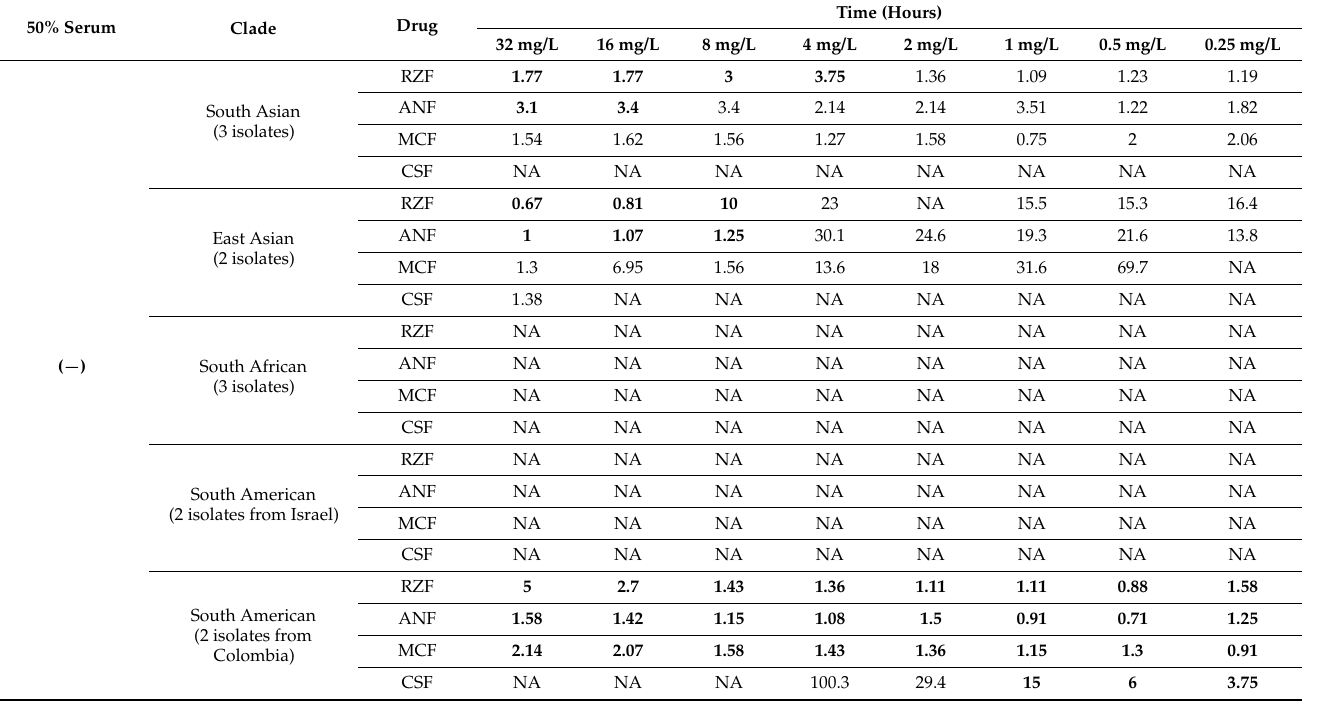
Table 2. Average time (hours) to reach 50% growth reduction (T 50 = 0.30103/ k ) from the starting inocula at different rezafungin (RZF), anidulafungin (ANF), caspofungin (CSF), and micafungin (MCF) concentrations in RPMI-1640 − /+ 50% human serum against 4 Candida auris clades. Data of the type strain (NCPF 13029 = CBS 10913) were not included in the data of the East Asian clade. Data in bold indicate that k values were positive (indicating killing) for all isolates within a clade, all other data (nonbold) indicate that one or two isolates never reached 50% growth reduction; the datum represents the average of those isolates in which the 50% growth reduction was reached. NA: 50% growth inhibition not achieved; ND: not determined.